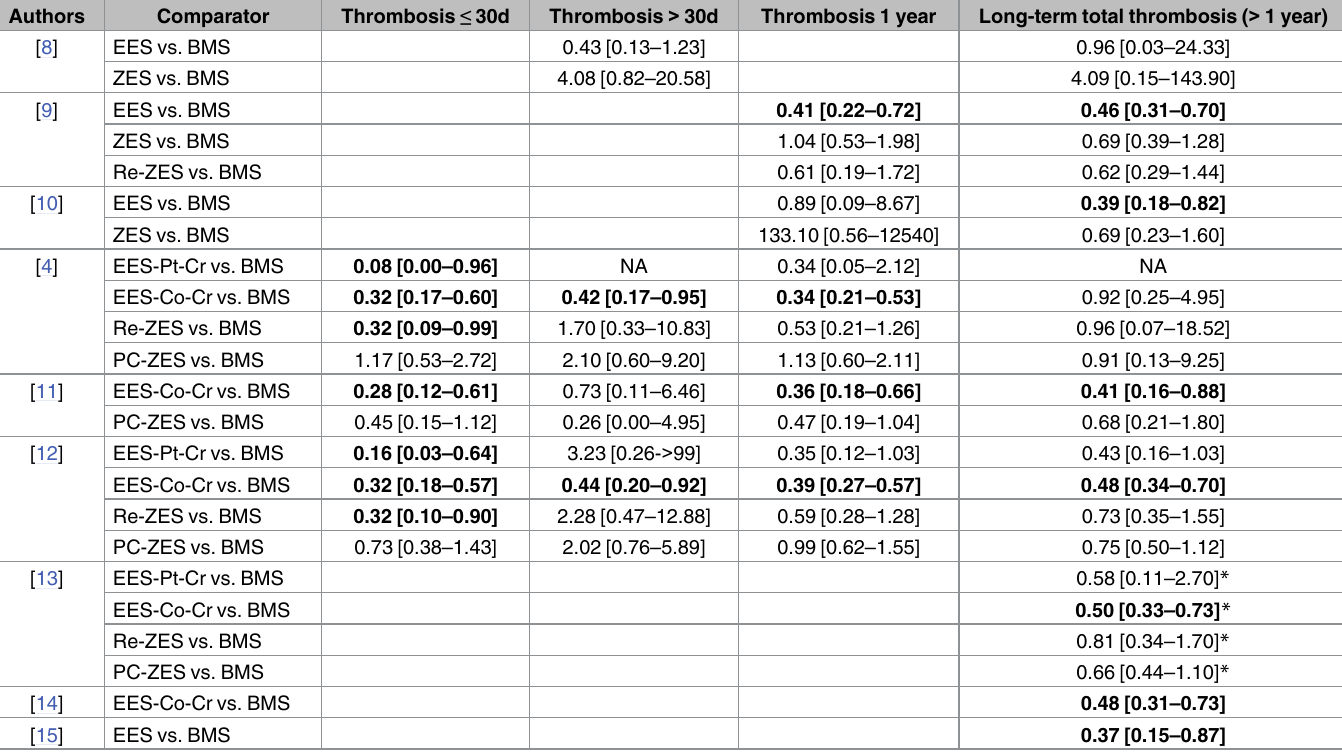
Table 5. Rate ratio of definite or probable thrombosis.